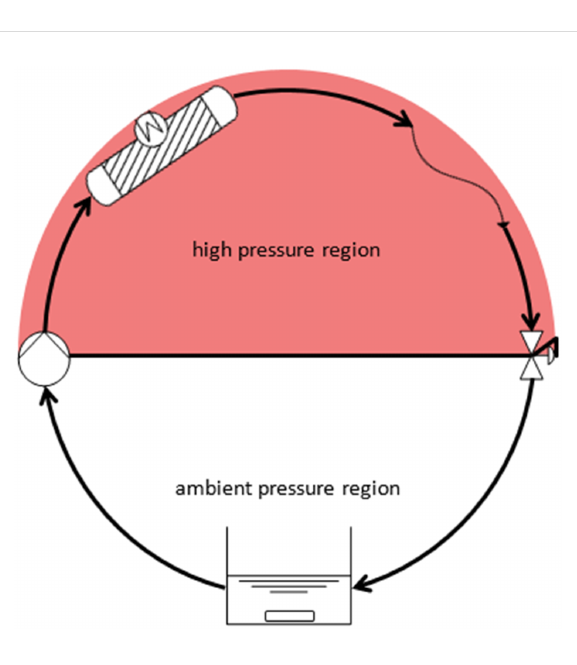
Figure 12: Circular reactor, vessel mixing was achieved with a mag- netic stirrer and samples were taken directly from the vessel.